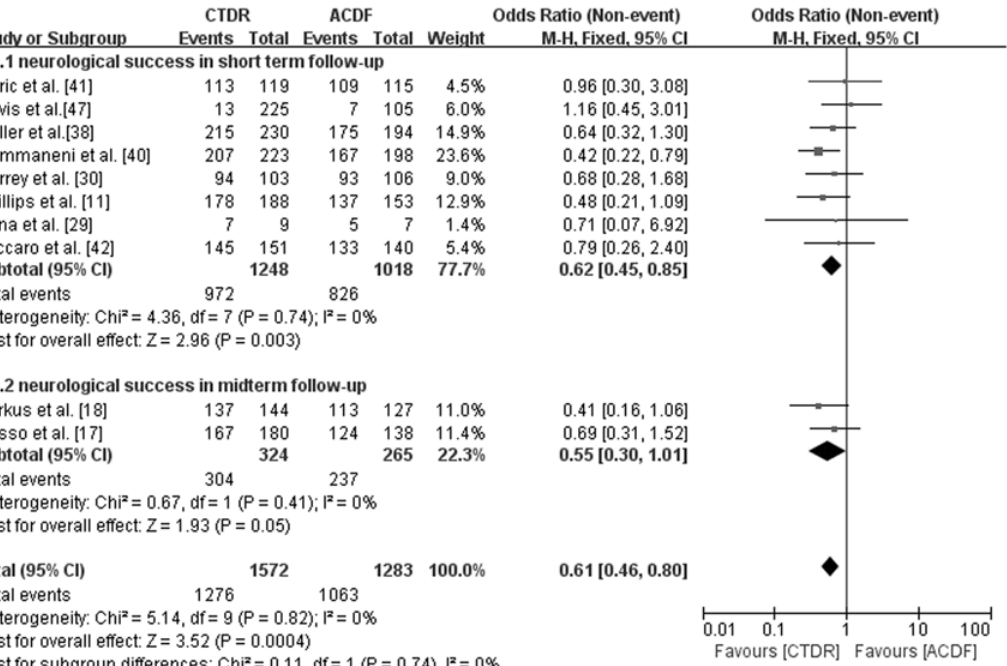
Fig 5. Comparison of Neurological success between the cervical total disc replacement (CTDR, experimental) group and the fusion (ACDF, control) group. MH = Mantel-Haenszel, CI = confidence interval, and df = degrees of freedom.